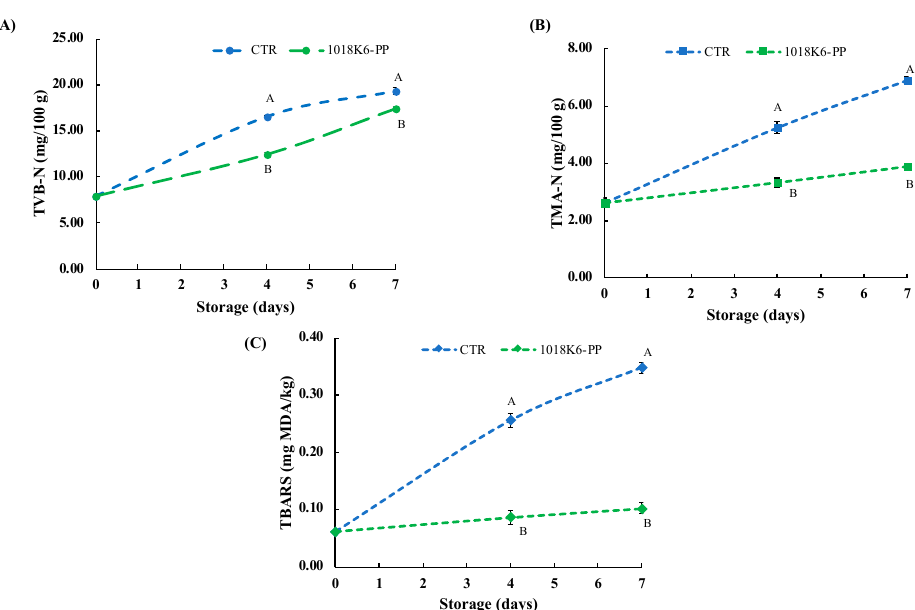
Figure 3. Effects of 1018k6-PP surfaces on the chemical quality of salmon fillets. ( A ) Changes in TVB-N (A), TMA-N ( B ), and TBARS ( C ) of Salmon salar fillets packaged in active 1018K6-PP films during storage at 4 °C. CTR (blue lines)—PP films without 1018K6; 1018K6-PP (green lines)—PP films functionalized with 1018K6. Results are means of three independent experiments and error bars represent the standard error (sem). Different letters at each sampling time are used for significantly different samples, according to Tukey test (uppercase letters: p < 0.01; lowercase letters: p < 0.05).